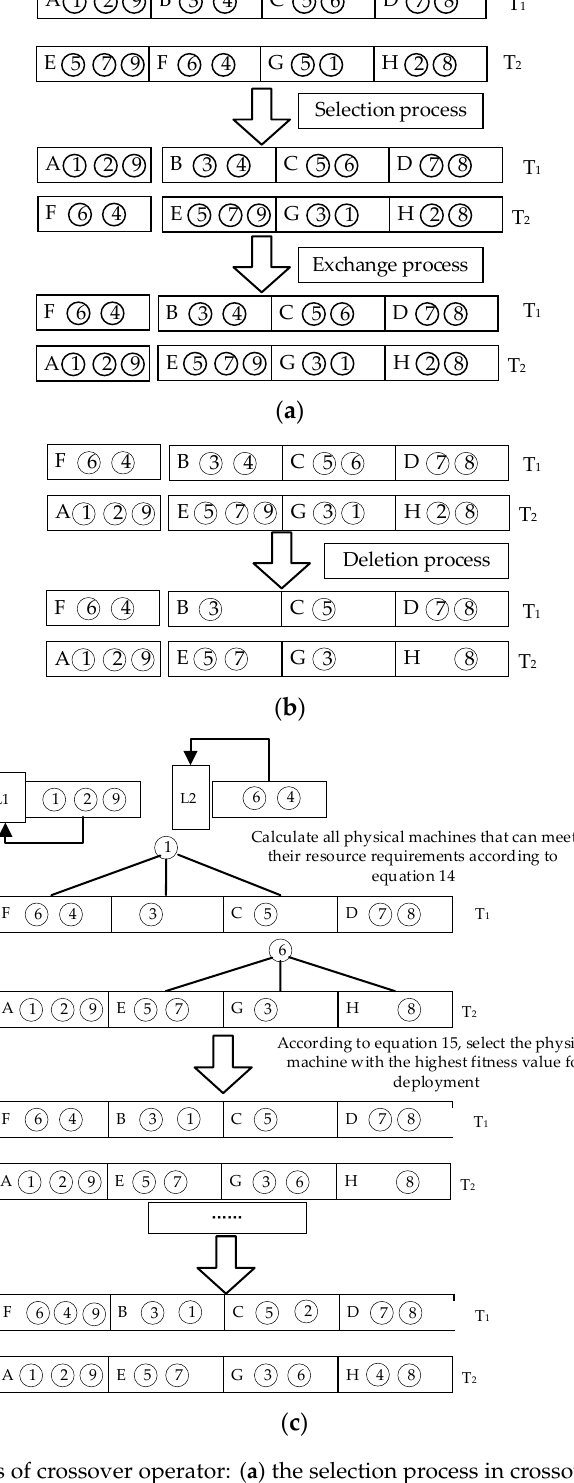
6 Selection process Deletion and re-add process Figure 5. The process of the mutation operation. 3.5. Algorithm Flow Steps of microservice resource scheduling based on the MFGA are shown in Figure 6. (1) Coding: Coding the problem based on the above model. (2) Population initialization: Initialize the population using the first adaptation algorithm to obtain the initial feasible solution. (3) Finding the fitness value: Calculate all individuals’ fitness values according to the resource scheduling model and fitness function. (4) Crossover operation: Based on the crossover probability of the algorithm, select crossover individuals and perform crossover operations based on the gene evaluation function to complete the update of the individual structure.